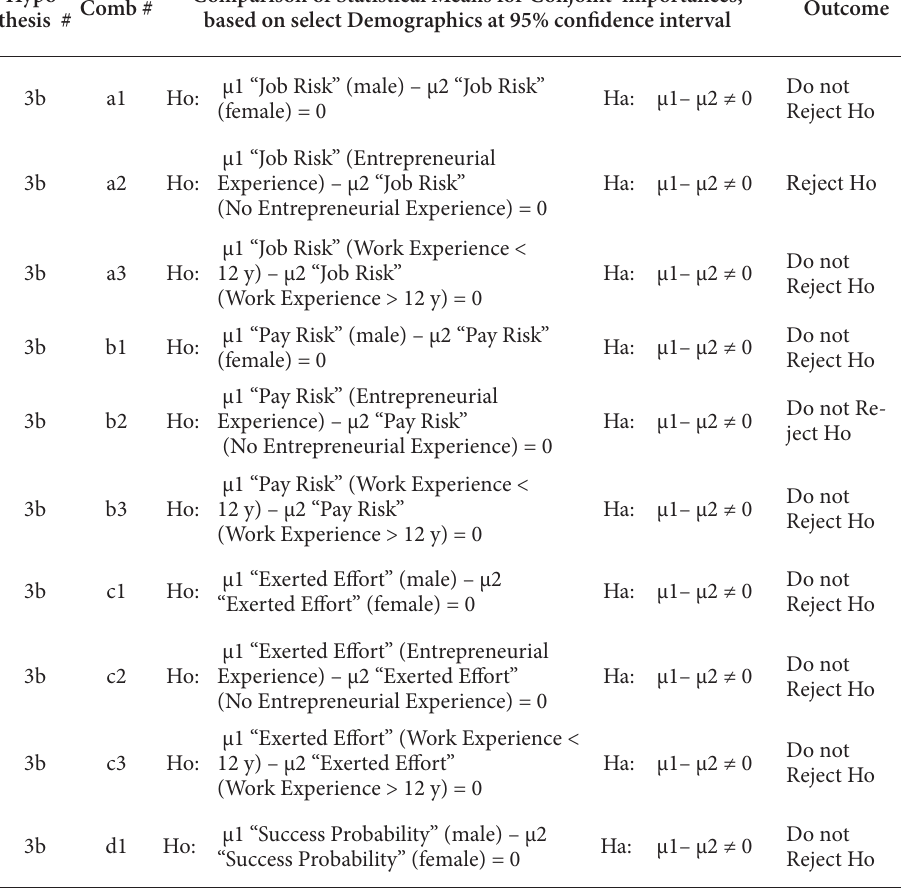
Table 5. Hypothesis 3b